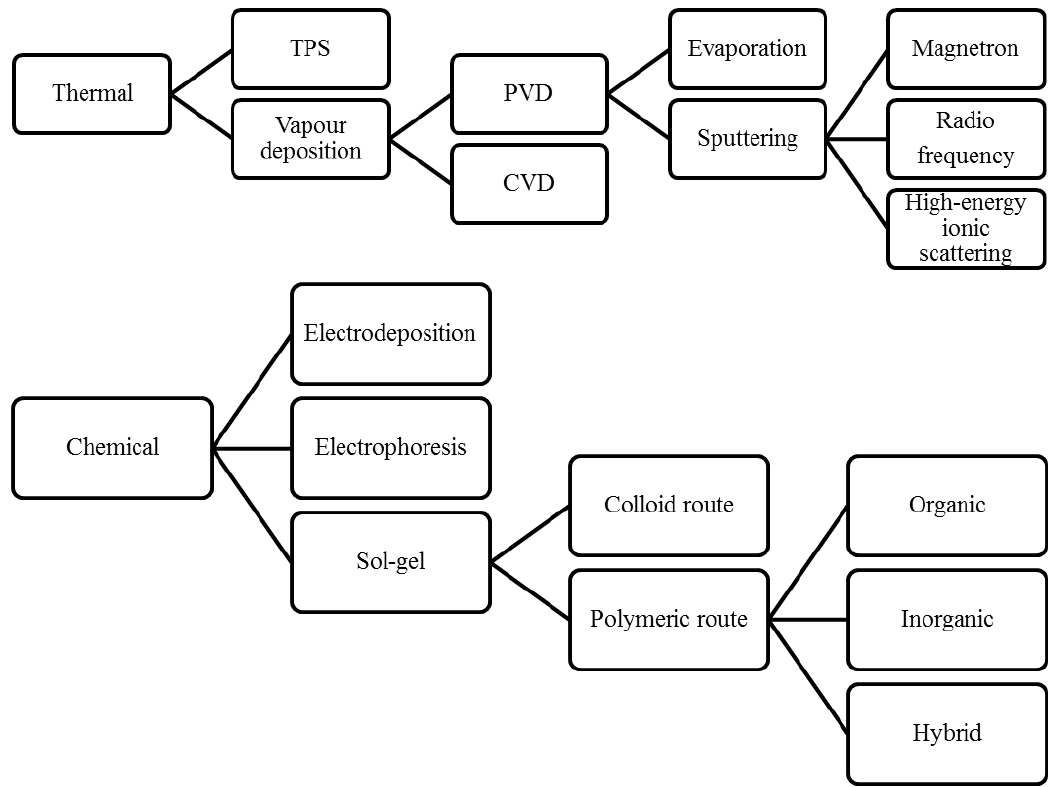
Figure 1. Classification of processes used for coating at the industrial level (extracted from Peláez-Vargas, A